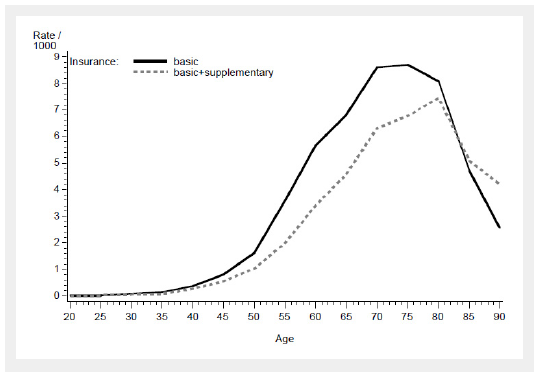
Figure 2 Incidence of total hip replacements in populations with basic or with basic plus supplementary health insurance.